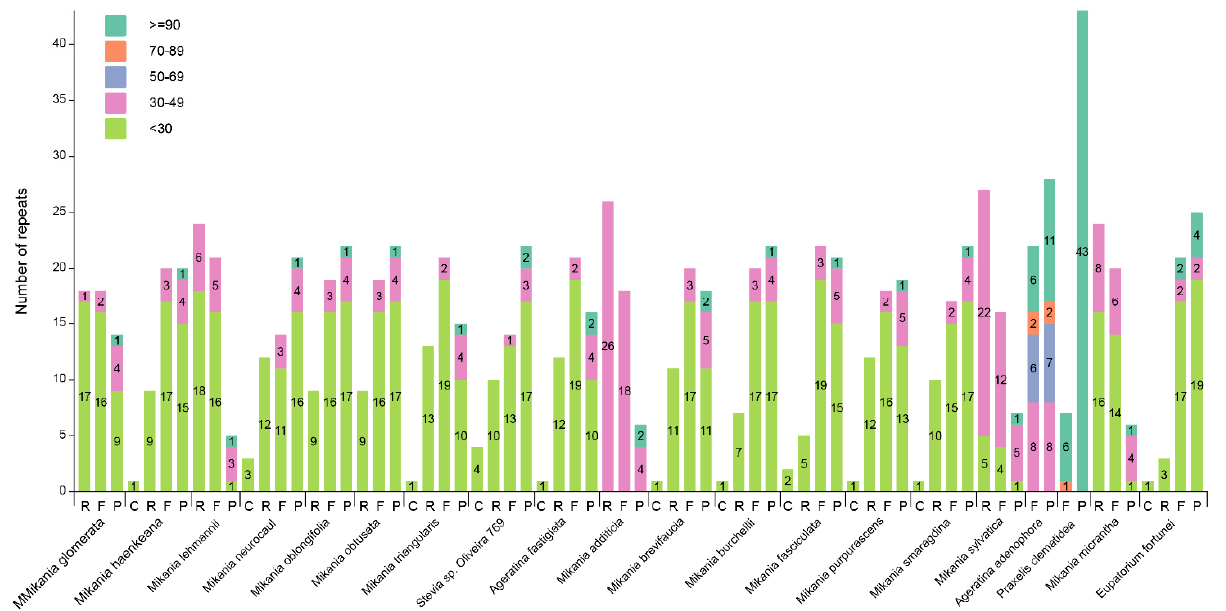
Figure 4. Analysis of long repeats in 20 different cp genomes. The x -axis represents the long repeat types, and the y -axis represents the numbers of corresponding long repeat types. F—forward repeat; R—reverse repeat; C—complement repeat; P—palindromic repeat. Different colors indicate different sizes of long repeat sequences.